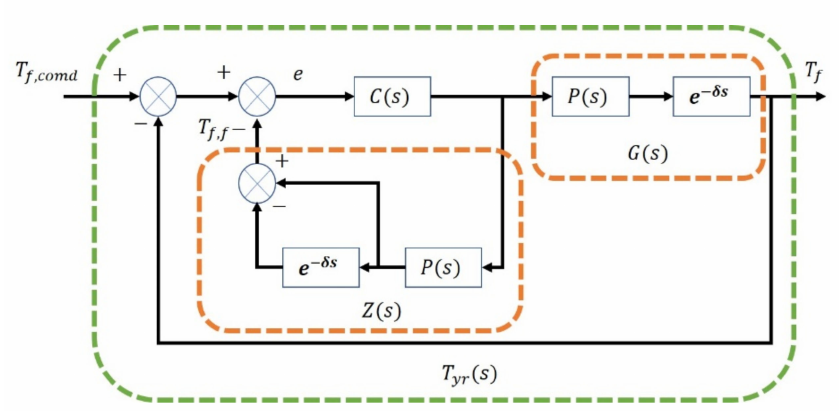
Figure 5. Input time-delay-based SP control